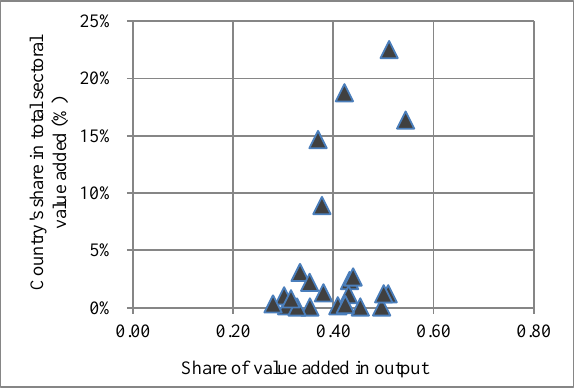
Fig. 3. Motion picture, video and television programme production, including programming and broadcasting activities in the EU in